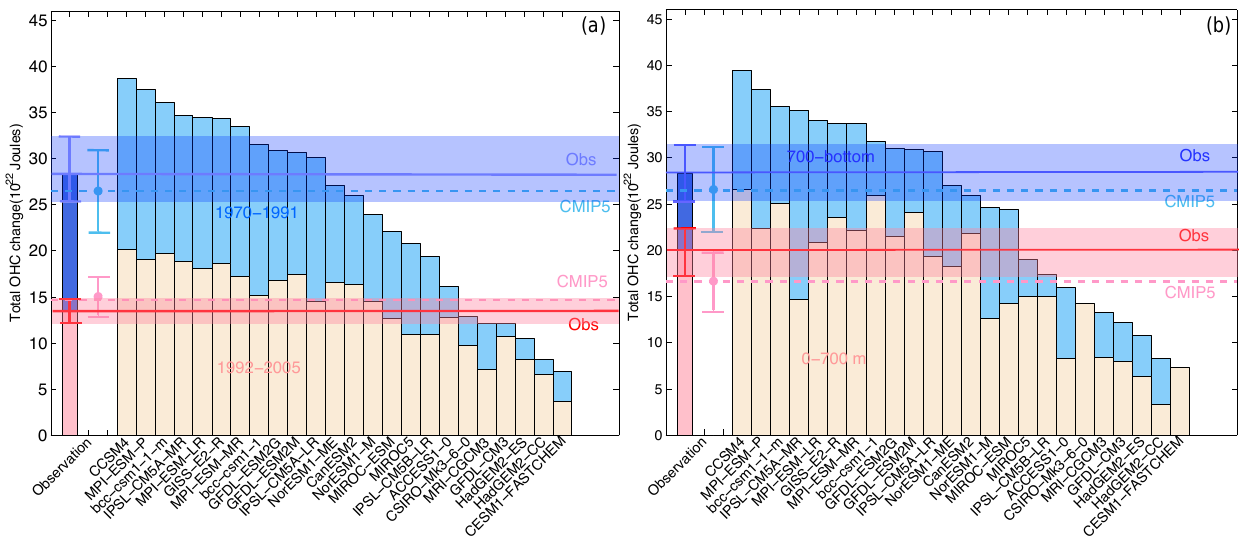
Figure 5. Comparison of full-depth OHC change between observation and CMIP5 models (a) for two separate time periods, 1970–1991 (in blue bars) and 1992–2005 (in red bars), and (b) for two vertical layers: 0–700m (in red bars) and 700m–bottom (in blue bars). The medians of the observational total OHC changes are shown in solid lines, compared with the model results in dashed lines. Their 5–95% confidence intervals are presented in error bars. The 5–95% confidence intervals for observations are also shaded in light red and light blue. A quadratic fit to the entire pre-industrial control run was used to correct the CMIP5 time series for model